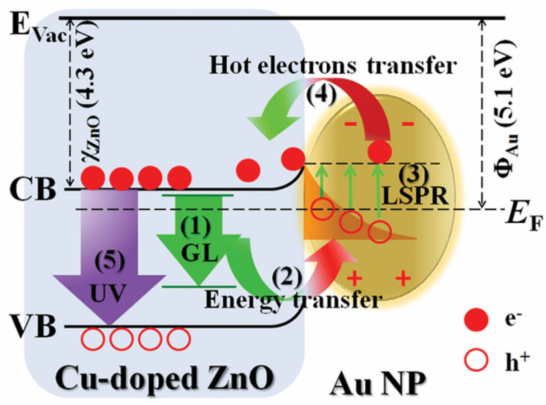
Figure 18. Schematic illustration of the possible mechanism of the UV enhancement involving the processes of (1) virtually generating green luminescence (GL) at Cu dopant, (2) transferring energy from the virtual GL of Cu-doped ZnO to localized surface plasmon resonance (LSPR) of Au NPs, (3) exciting LSPR of Au upon receiving the transferred energy from the virtual GL, and generating plasmonic hot electrons as a result of nonradiative decay of the LSPR, (4) transferring hot electrons from Au to the conduction band of Cu-doped ZnO, and (5) excitons radiative recombination at Cu-doped ZnO into UV emission (Reproduced with permission from Reference [176] published by John Wiley and